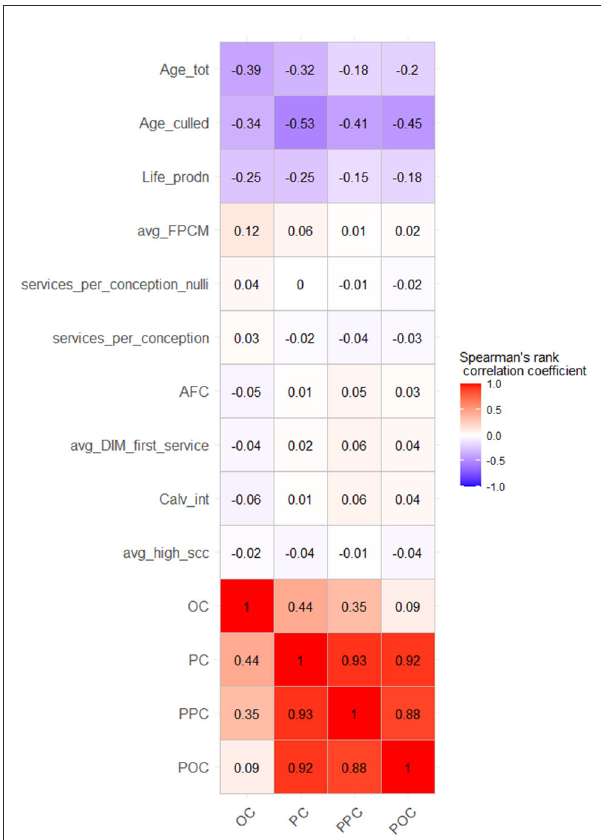
FIGURE2 Spearman’s rank-correlation matrix of correlations between the four culling proportions and performance indicators. Age_tot, total herd average age; Age_culled, herd average age of culled cows; Life_prodn, lifetime production of milk; Avg_FPCM, herd average daily fat-protein corrected milk; services_per_conception_nulli, mean number of inseminations per calf (in nulliparous cows); services_per_conception, mean number of inseminations per calf (in multiparous cows); AFC, age at first calving; avg_DIM_first_service, interval of days in milk (DIM) between last calving and first insemination; Calv_int, herd average calving interval; avg_high_scc, proportion of cows in herd with high somatic cell count; OC, overall culling proportion; PC, primiparous culling proportion; PPC, primiparous-primiparous culling proportion; POC, primiparous-overall culling